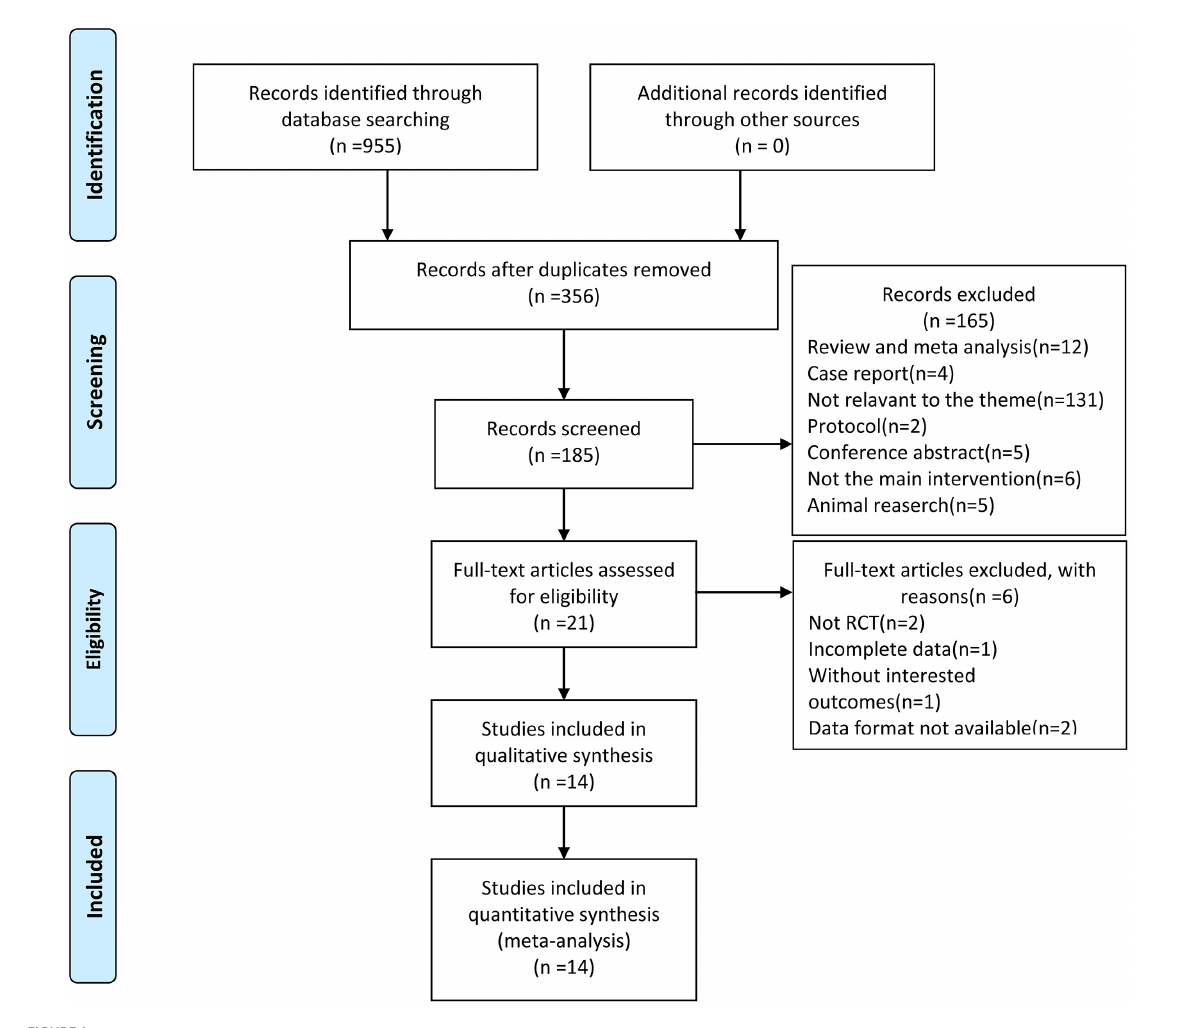
FIGURE1 Flow of the trial selection